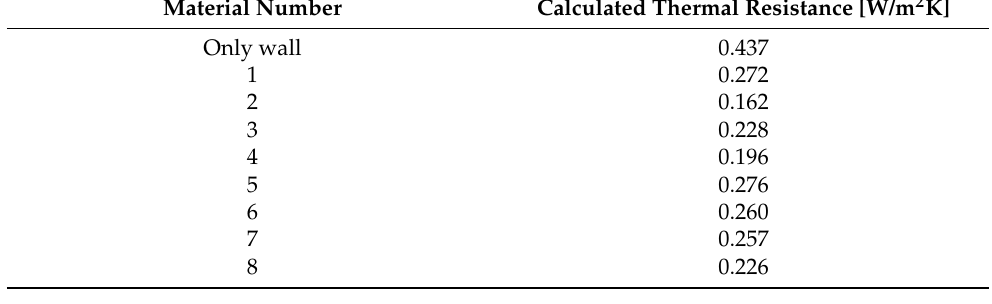
Figure A3. Wall type 2: stratigraphy with thicknesses and conductivities for the different layers. The numbers start from the outside. Table A2. Wall type 2: thermal transmittance reached with different heat-reflective materials. Material Number